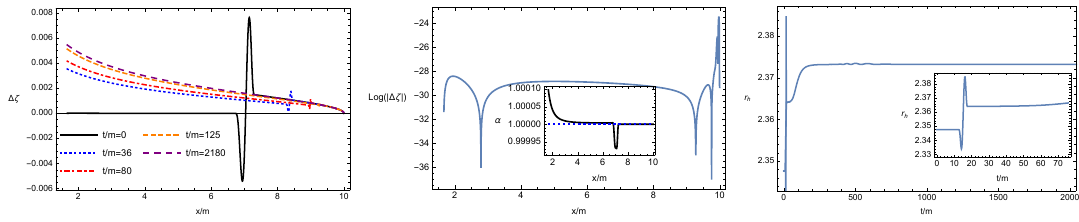
Figure 9 . The temporal evolutions of the relevant metric functions. Left: the deviation ∆ ζ of the metric function ζ from that of the initial HBH metric, evaluated as a function of x/m for different time instants. Middle: the logarithmic deviation ln ∆ ζ of the late-time asymptotic metric function | | ζ from that of a static BBH of the same mass, evaluated as a function of x/m . The solid black curve shown in the inset gives the initial profile of α , while the blue dashed one corresponds to its value at t/m = 2180. Right: the radius of black hole horizon as a function of t/m